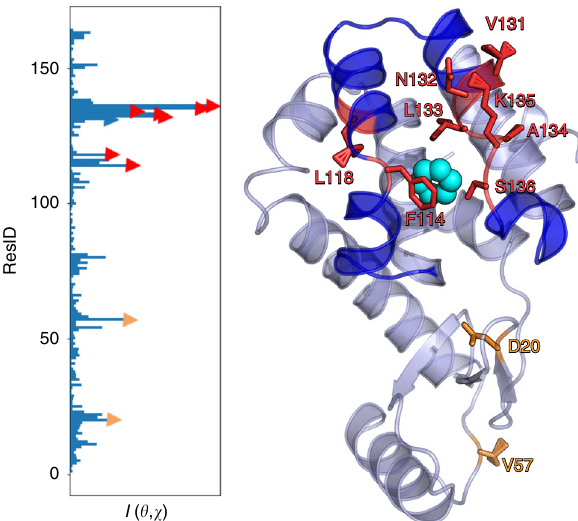
Fig. 5 Critical residue analysis for benzene – lysozyme complex. The plot on left shows for every residue the maximal mutual information between the predictive information bottleneck (PIB) and either of the Ramachandran angles ϕ , ψ of that residue. The top 10 residues are highlighted through markers and in the right plot, illustrated relative to the ligand in a typical